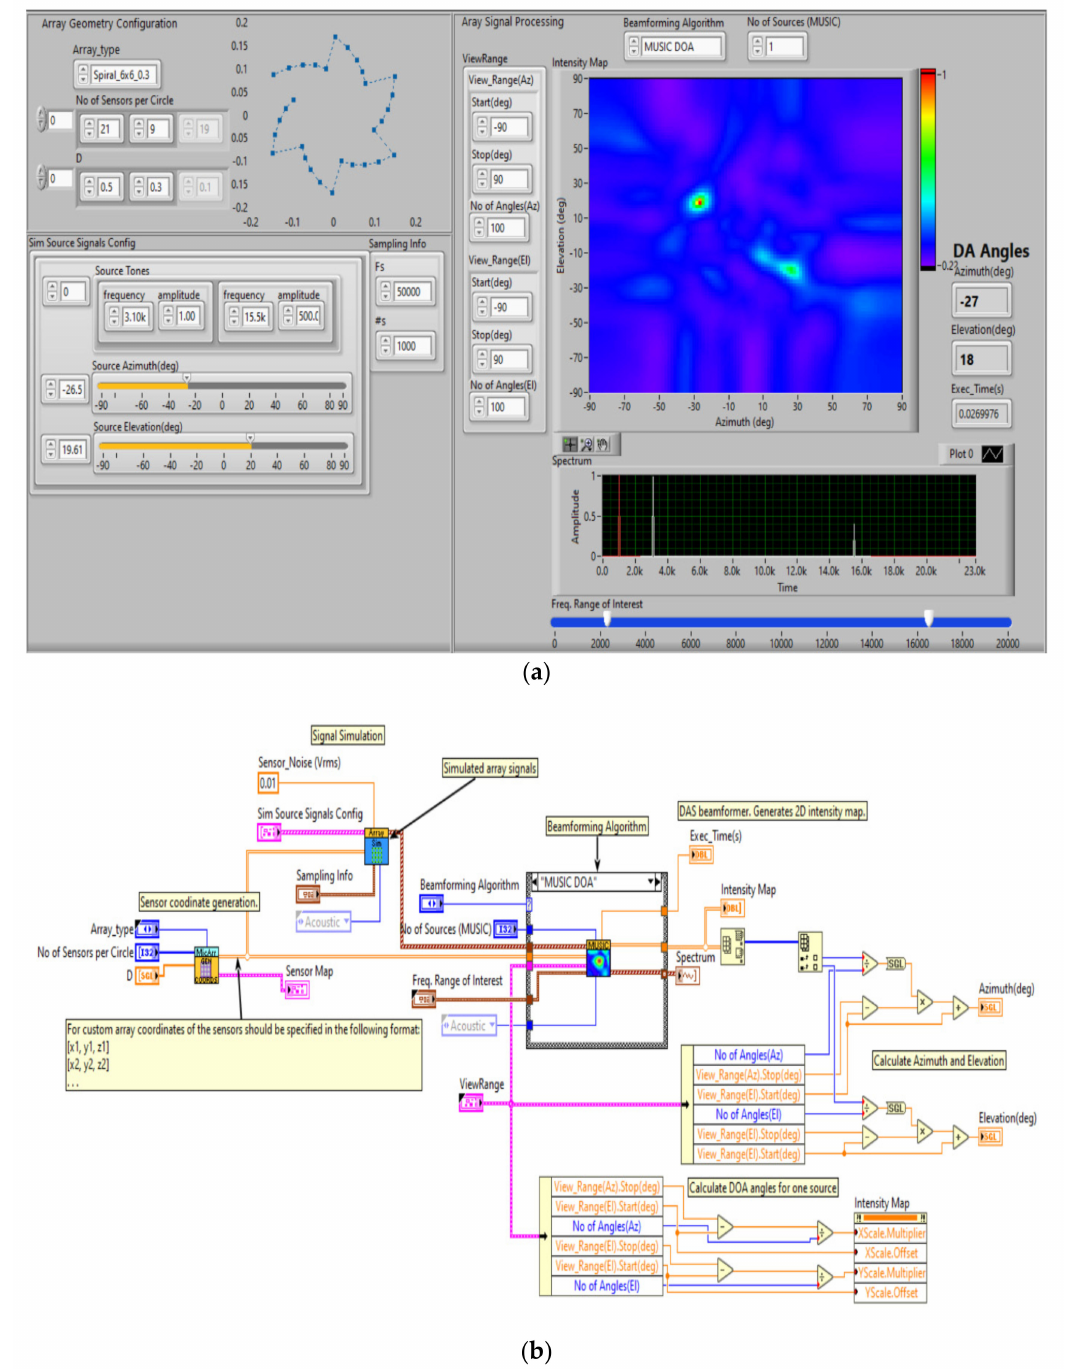
Figure 3. Simulation Spiral Microphone Array. GUI beamforming analysis using acoustic frequency characteristic of UAVs ( a ) and software implementation ( b